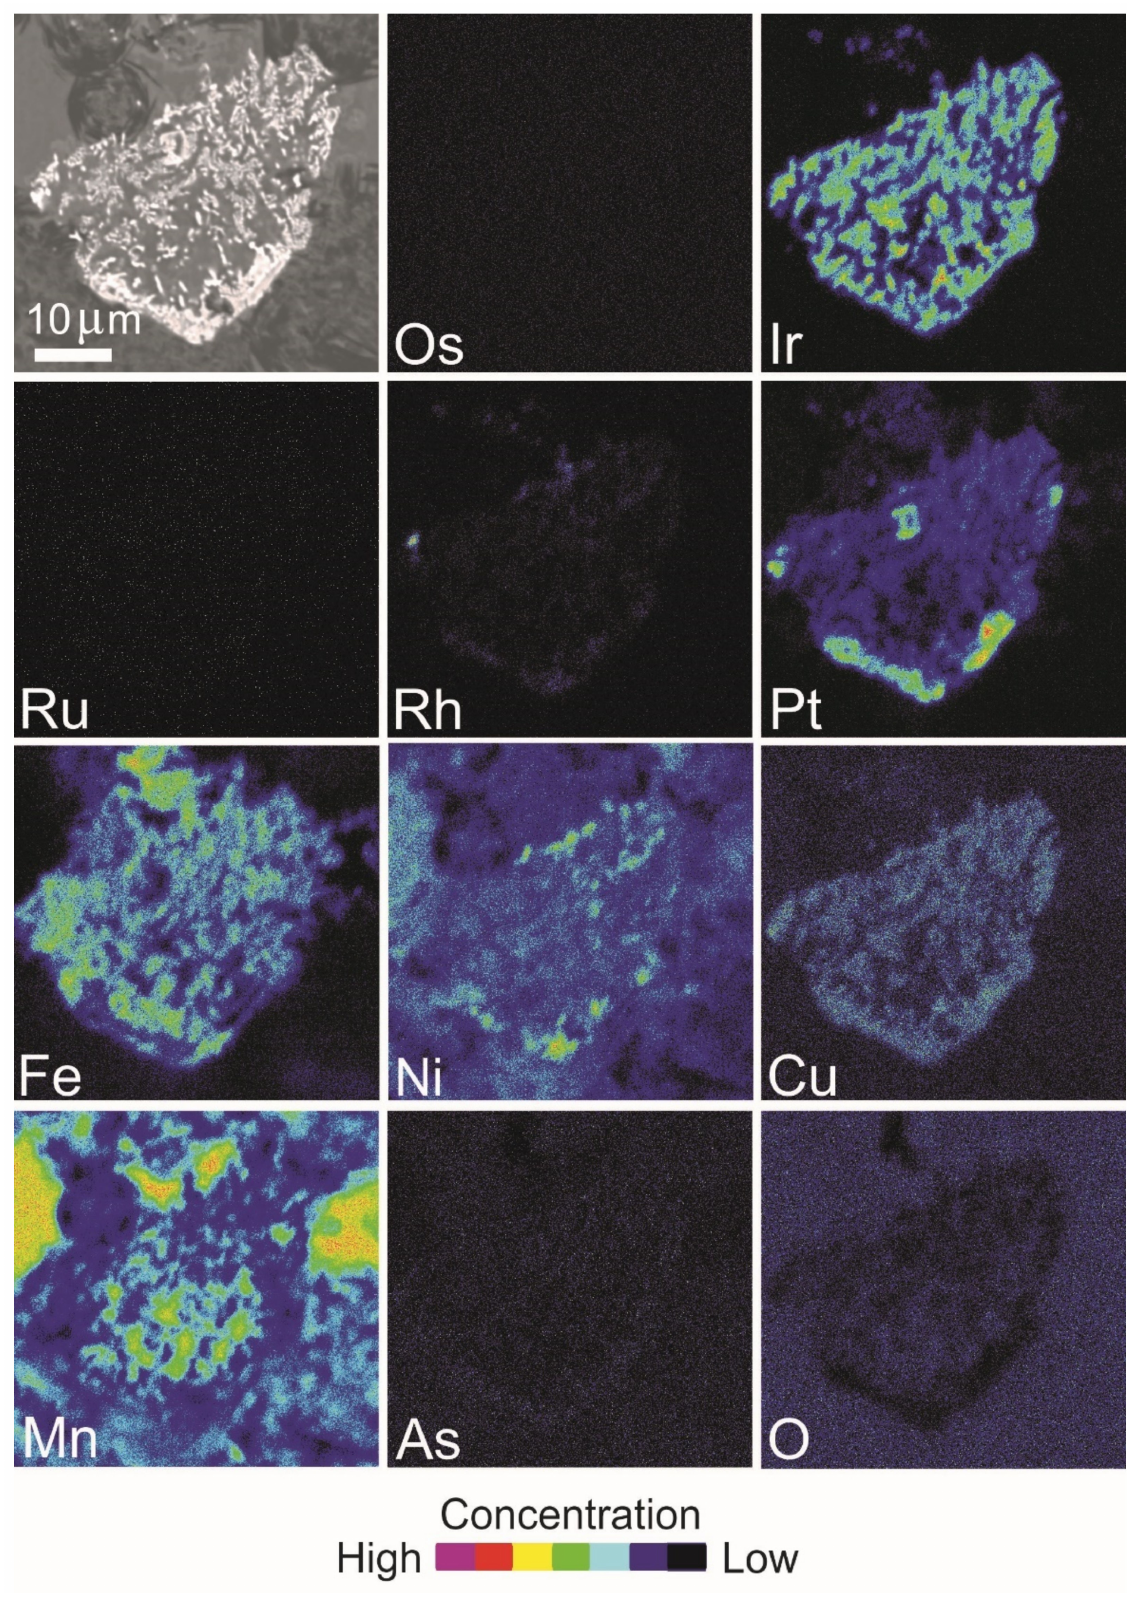
Figure 17. BSE image and X-ray elemental distribution maps of Os, Ir, Ru, Rh, Pt, Fe, Ni, Cu, Mn, As and O in the PGM shown in Figure 14E,F, composed of iridium and a Pt